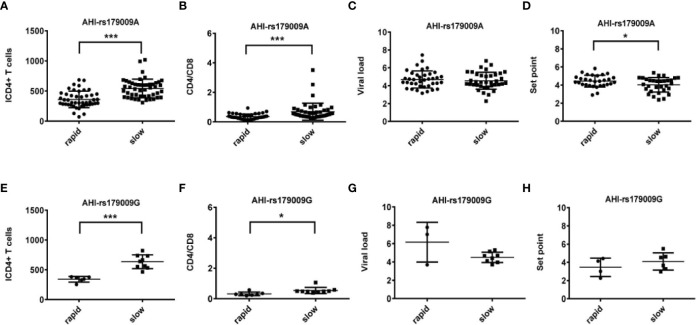
Relationship between clinical parameters and AHI patients with rapid/slow progression who carry rs179009A/G. (A–H) There are four clinical parameters including, ICD4 (initial CD4 T cells) (A, E), CD4/CD8 (the ratio of CD4 versus CD8 T cells) (B, F), viral load (C, G), and set point (D, H). The y axis indicates the values of these four respective parameters. The x axis, indicates two AHI patient groups with rapid or slow progression. The text on the top of each picture indicates allele rs179009A/G. Each dot represents an MSM individual, (●) represents individuals of AHI-rapid progress with TLR7 rs179009A/G allele. (■) represents individuals of AHI-slow progress with TLR7 rs179009A/G allele. *indicates P < 0.05; P < 0.01 and ***P < 0.001.